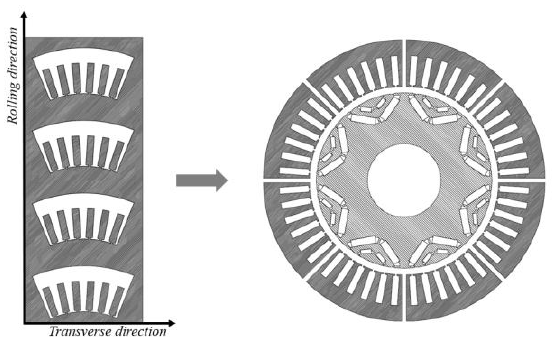
Figure 4. Example of GO laminations cutting to be installed in a 48 s/8 p IPM modular machine.